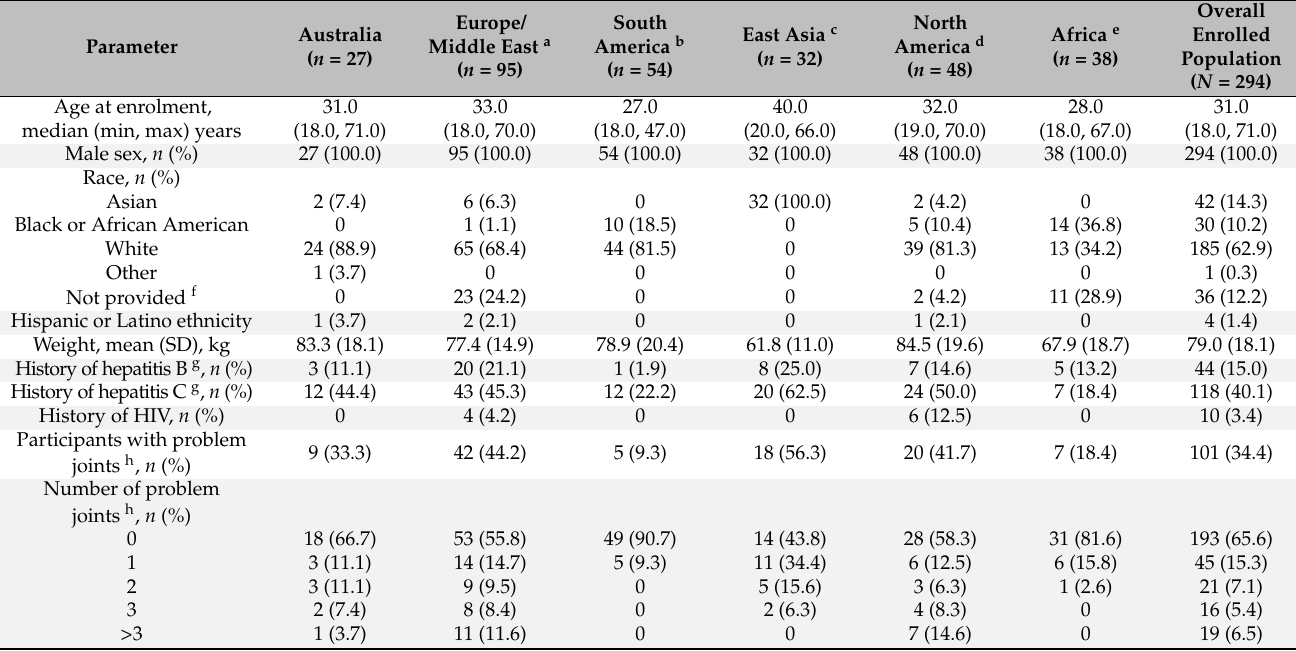
Table 1. Patient demographics and baseline characteristics.